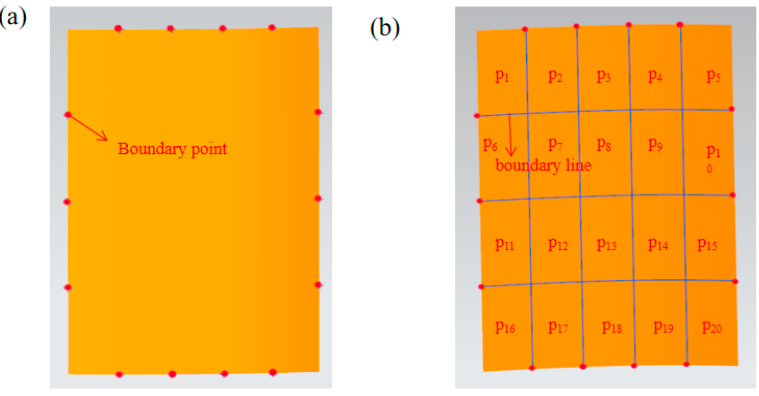
Figure 7. Region division of ruled blade P: ( a ) distribution of boundary points, ( b ) region division of blade.